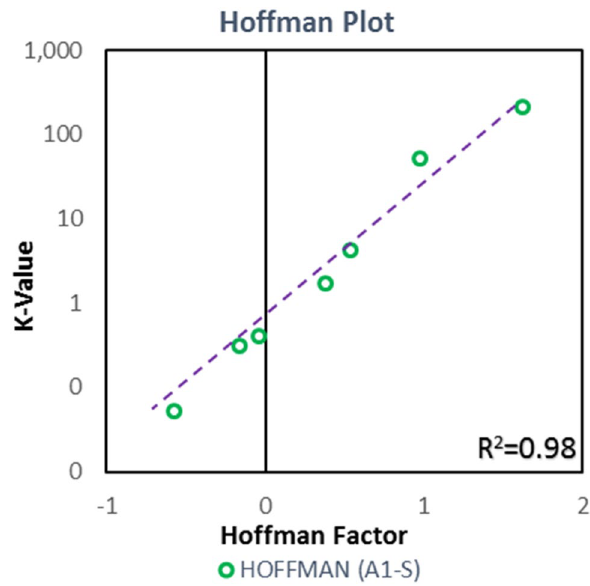
Fig. 19 Valid Buckley plot—recombination